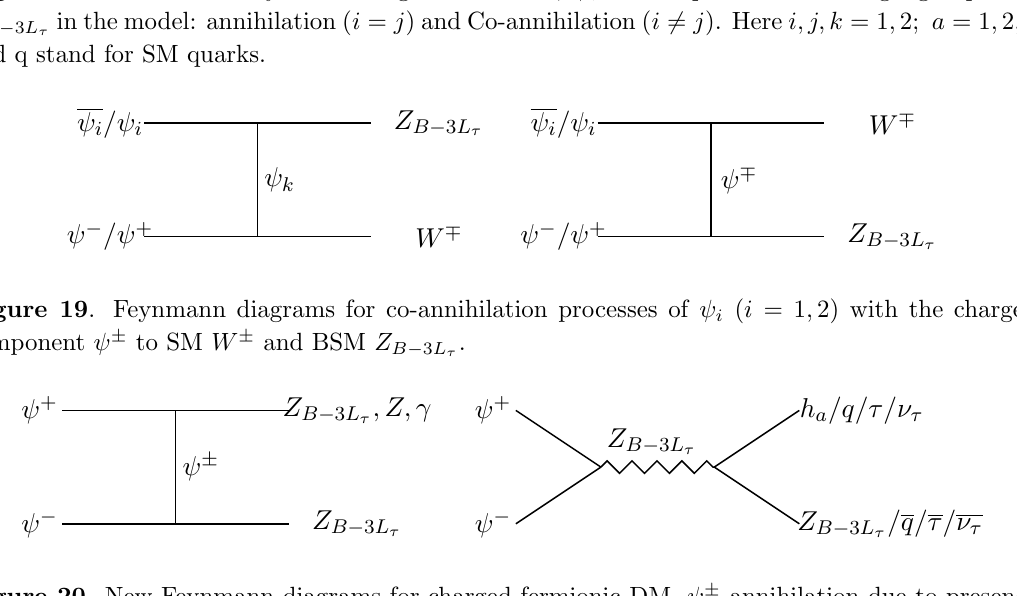
Figure 20 . New Feynmann diagrams for charged fermionic DM, (cid:6) annihilation due to presence of new gauged paricle Z B (cid:0) 3 L . Here a = 1 ; 2 ; 3. (cid:28) Open